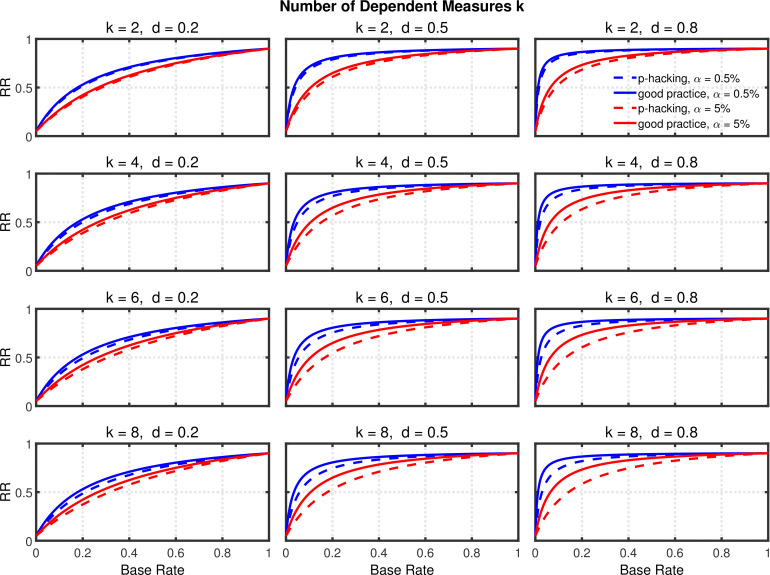
Failing to report all dependent measures.Replication rate (RR) as a function of base rate π, number of dependent measures k, effect size d, and nominal α level (0.5% or 5%). The nominal α level and power of the replication study are α2=5% and 1-β2=90%. All results are based on two-sample tests with n=20 participants per group and dependent measure intercorrelations of 0.8.